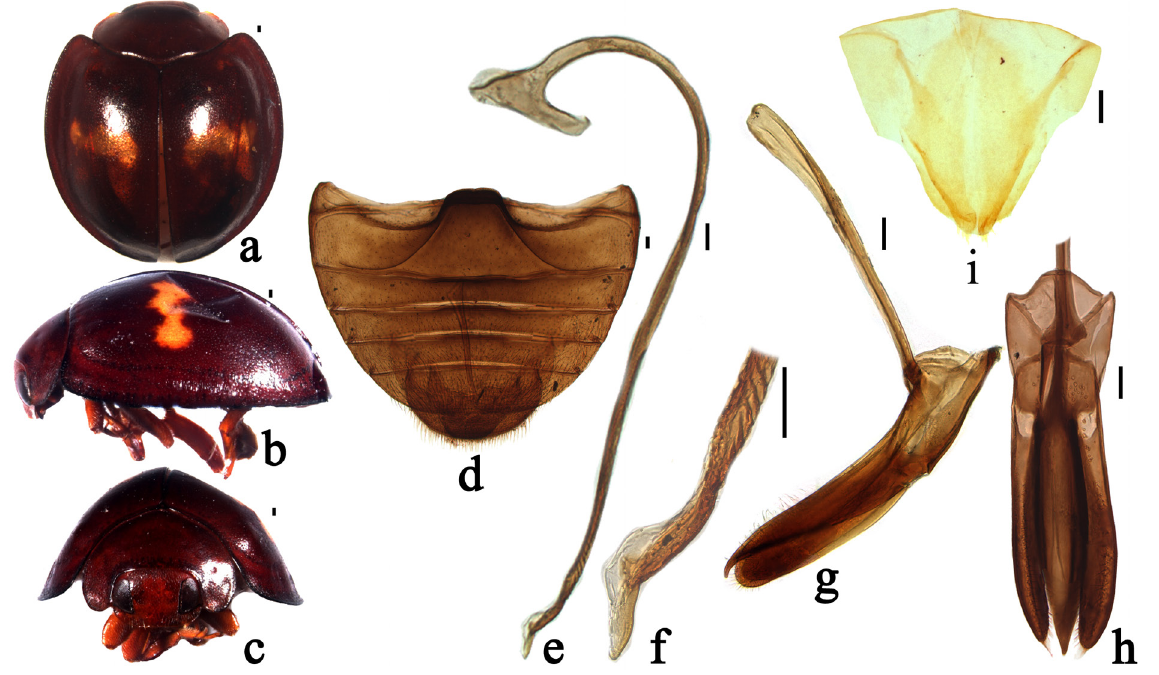
Fig. 20. Chilocorus geminus Zaslavskij, 1962. a . Dorsal view. b . Lateral view. c . Frontal view. d . Abdomen. e . Penis. f . Apex of penis. g . Tegmen, lateral view. h . Tegmen, ventral view. i . ovipositor. Scale bars: 0.1